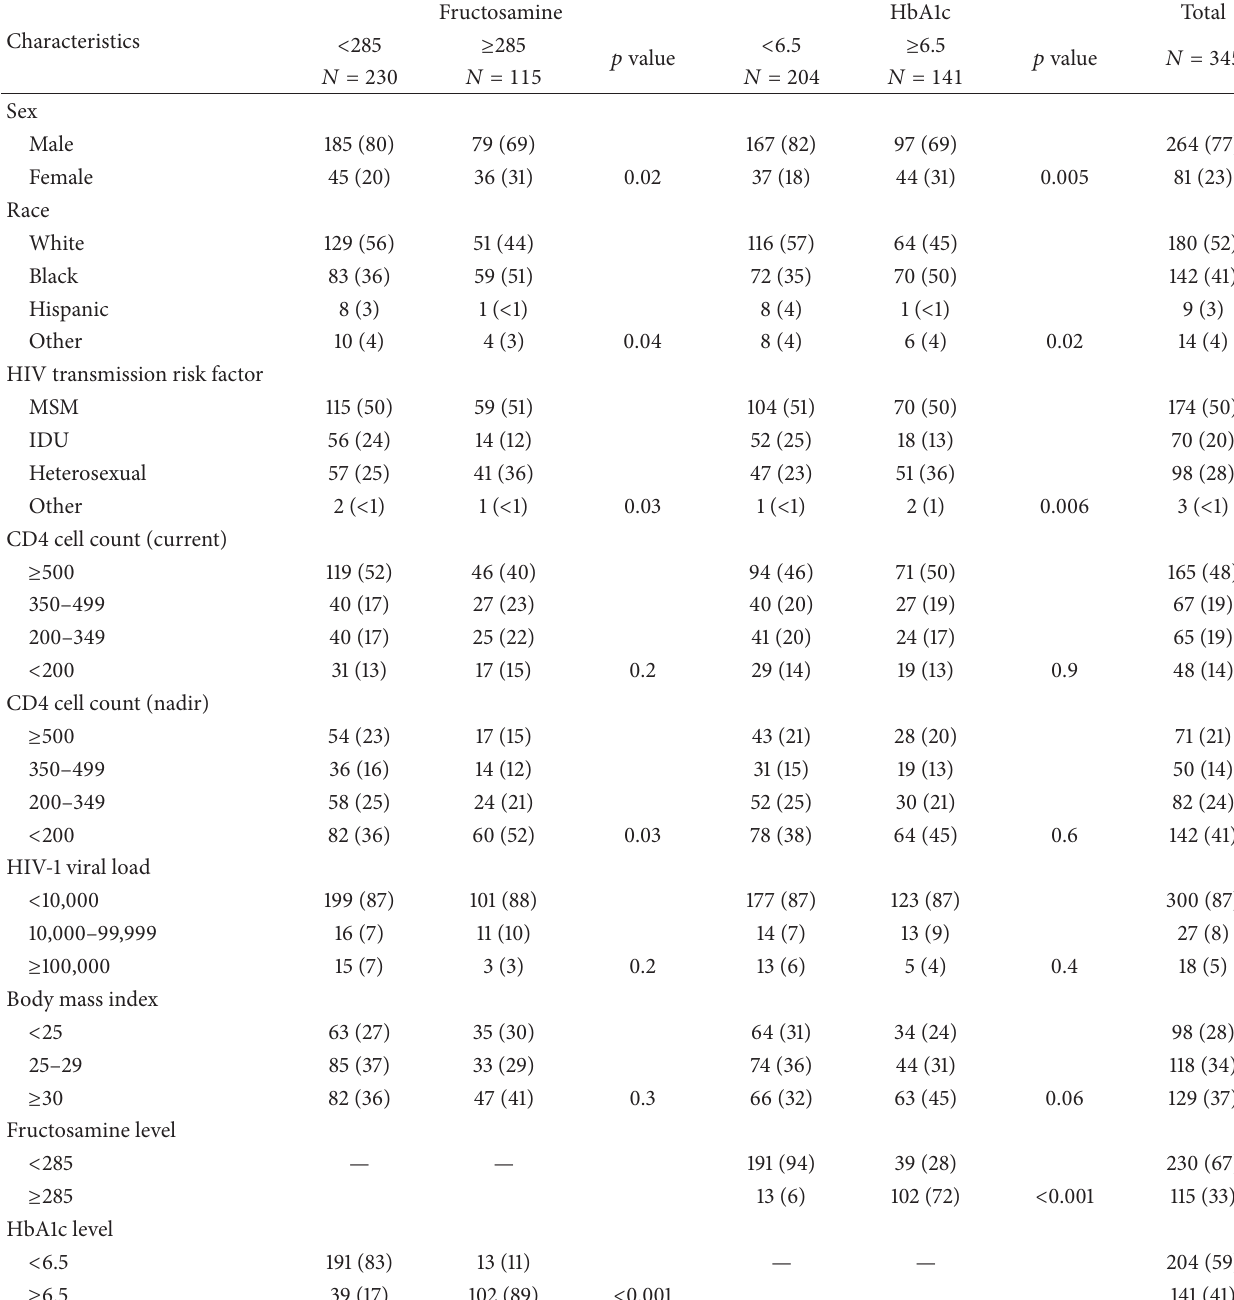
Table 1: Demographic and clinical characteristics ( 𝑁 = 345 ).